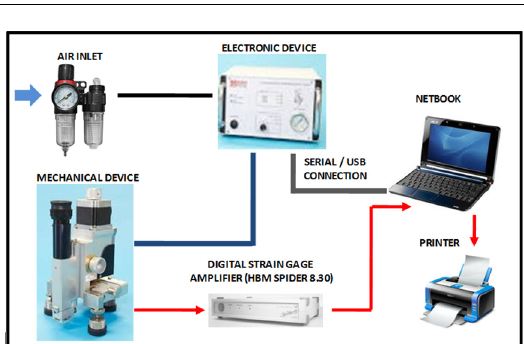
Figure 2. Schematic of the integrated system for measuring residual stress by blind hole technique applied